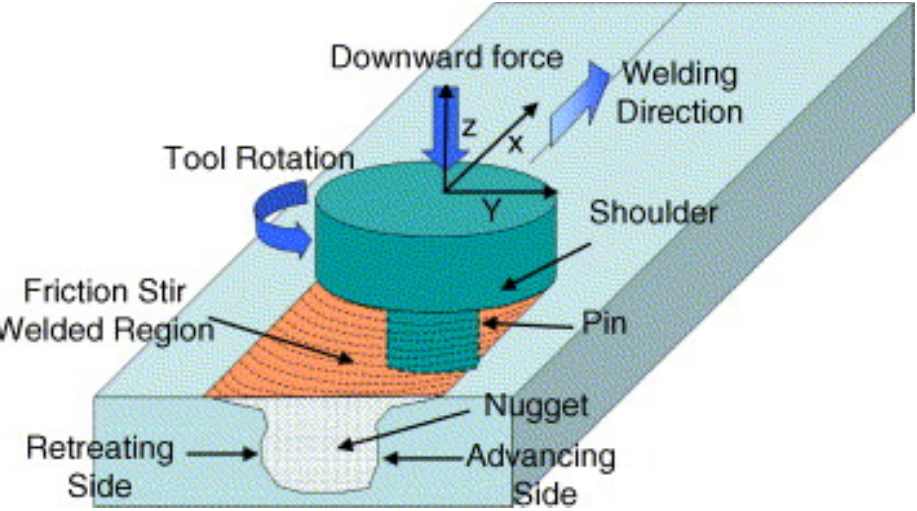
Figure 11. Schematic of FSW process. Reproduced with permission from [95]. Copyright Elsevier, 2005.